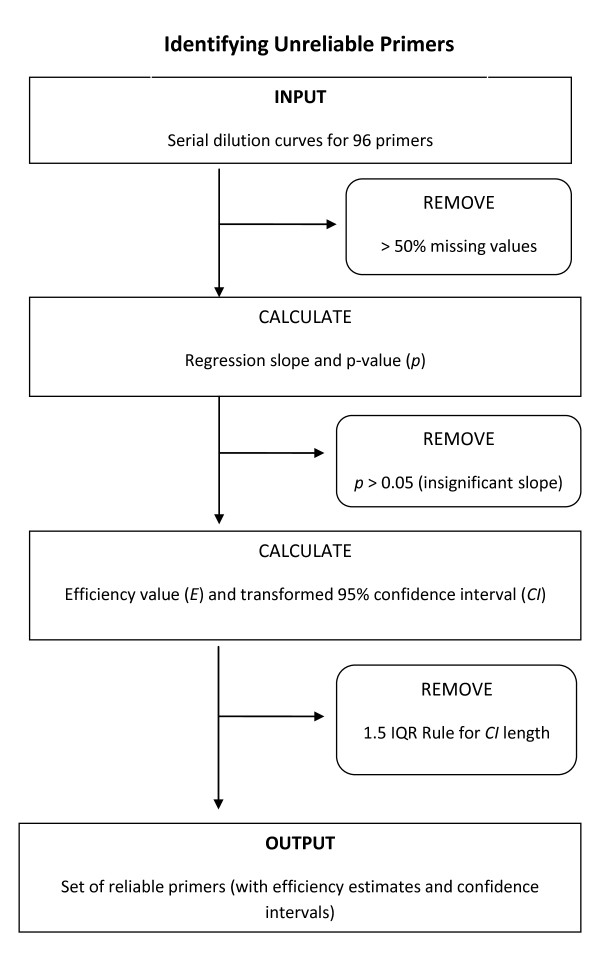
Flow chart for estimating efficiency with confidence and identifying unreliable primers.